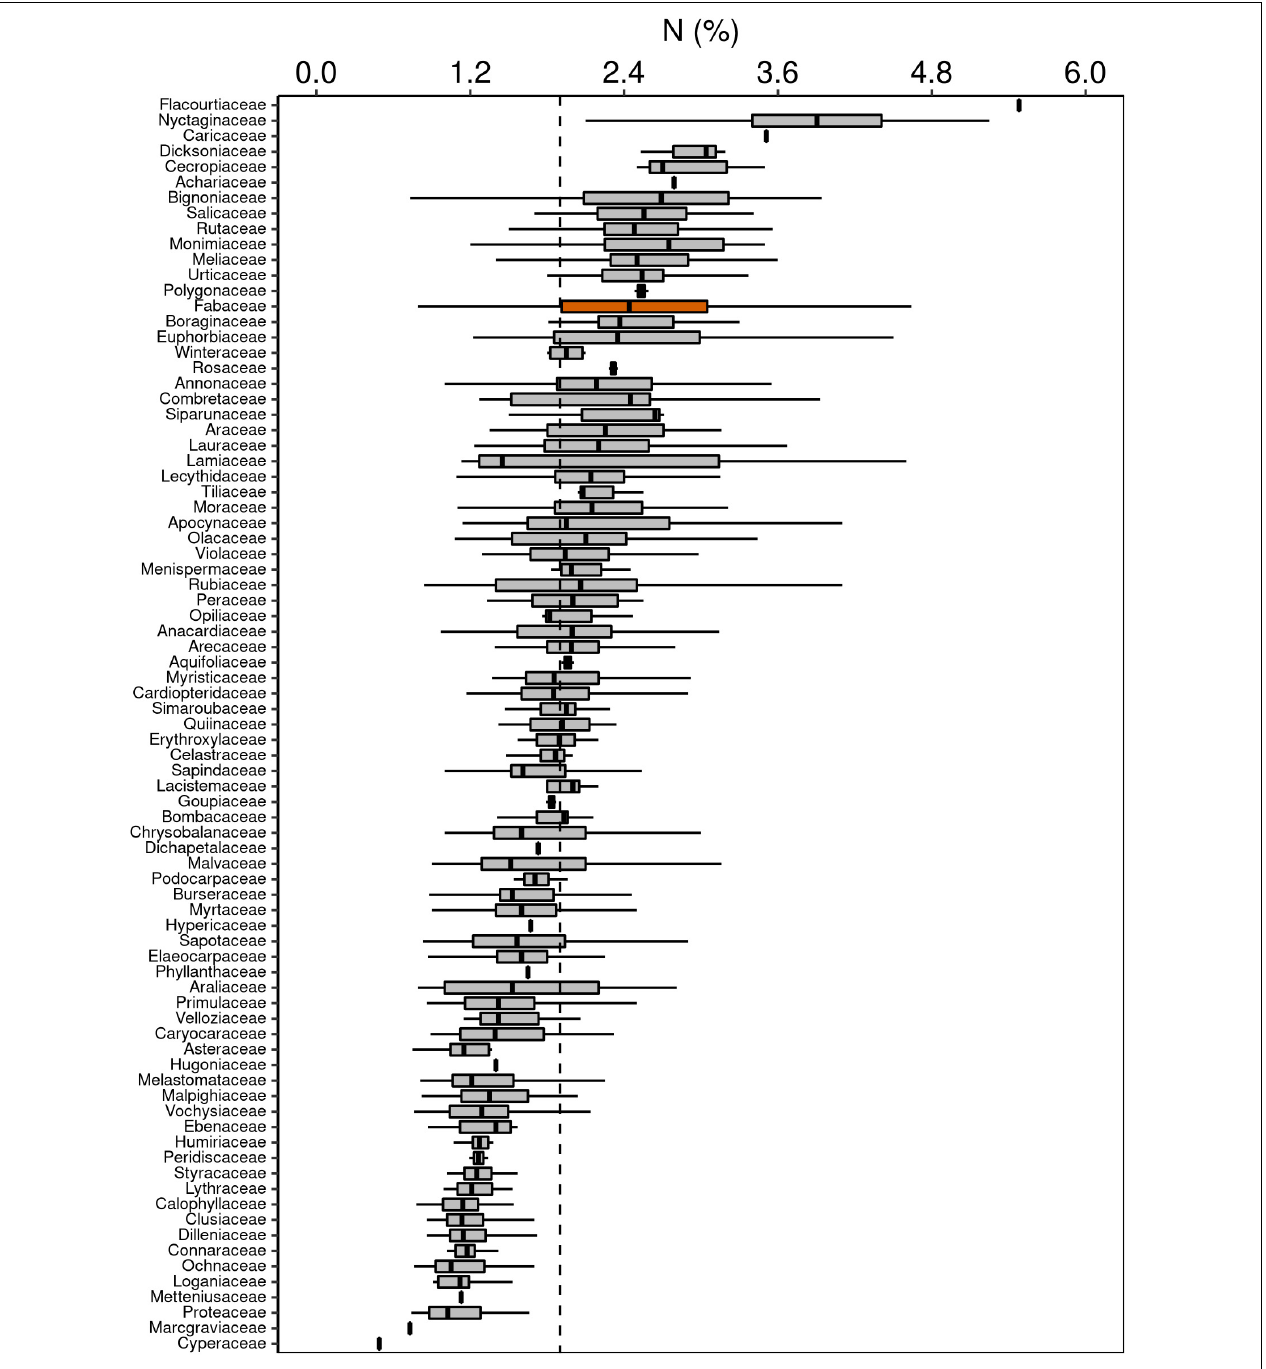
FIGURE 3 | Box-plots of foliar N concentration of botanical families in decreasing order. The vertical lines inside each box represent the median; the box represents the first and third quartiles; and the bars represent the interquartile range. The vertical dashed line represents the mean of the entire population. The orange box is evidencing the Fabaceae family, where a notable part of the species is capable of fixing atmospheric N through symbiotic